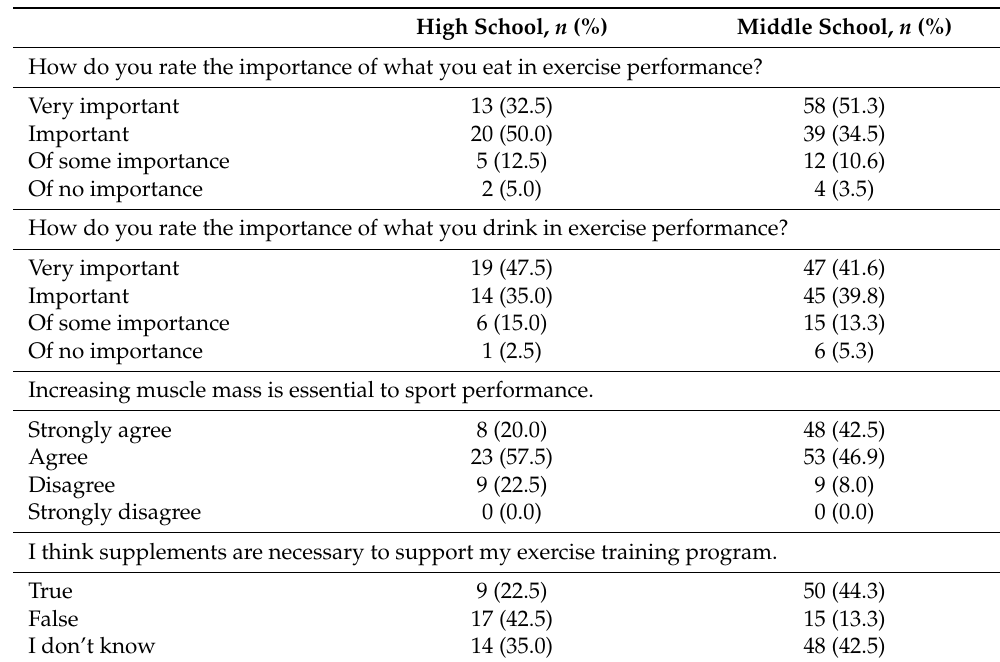
Table 3. Nutrition and exercise performance beliefs.